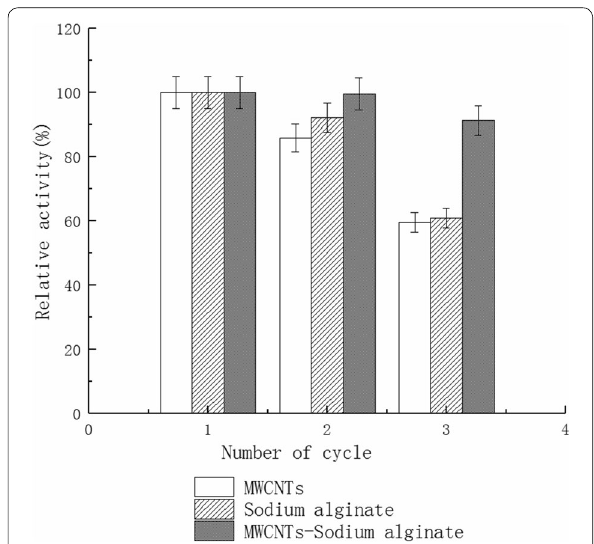
Fig. 7 Reusable hydrolysis CMC by the immobilized cellulase of different materials